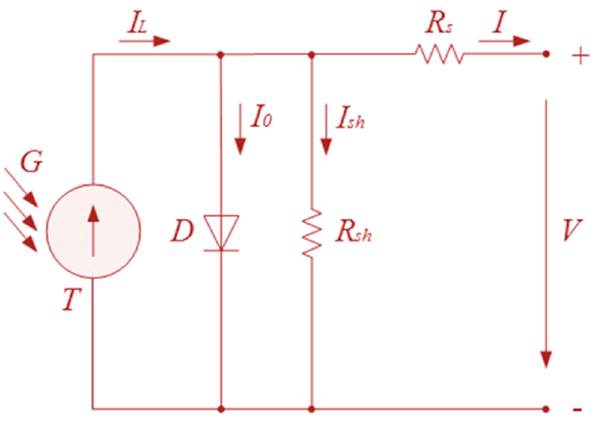
Figure 2. Schematic diagram of the single − diode circuit.